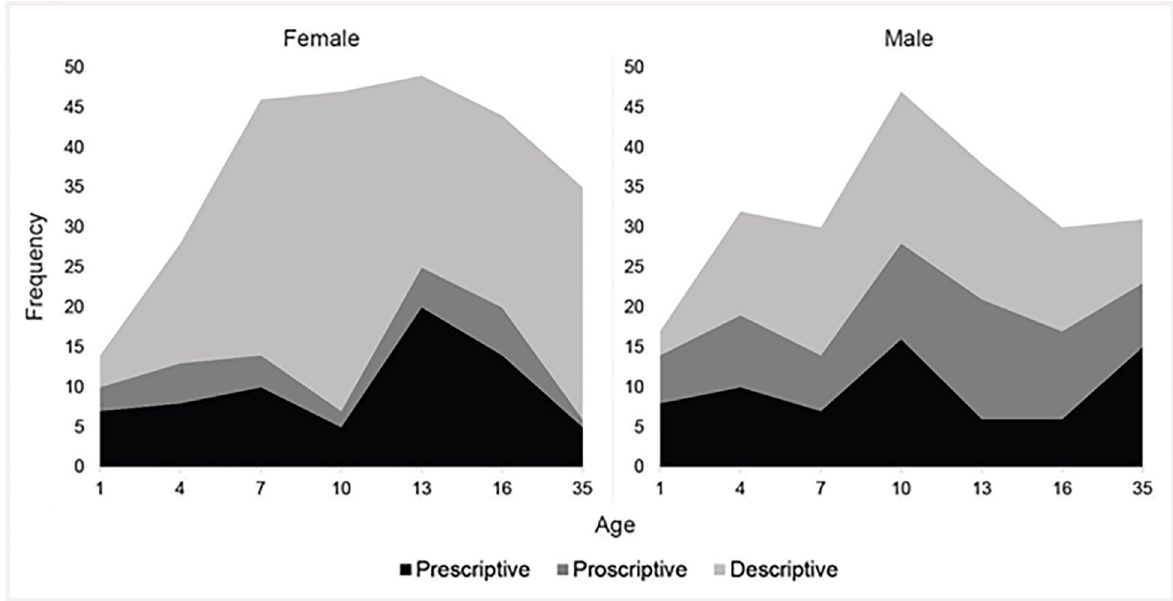
Fig 2. Number of characteristics classified as gender stereotypes at each age by type of stereotype. Notes . Y-axis is a count of stereotypes that met our pre-registered stereotype threshold. Black indicates prescriptive stereotypes, dark gray indicates proscriptions, and light gray indicates descriptive stereotypes. Note that some characteristics are double-counted (e.g., if an item was a descriptive and prescriptive stereotype at a particular age, it contributes to both the descriptive count and the prescriptive count). These data suggest that gender stereotypes are prevalent across the developmental timeline, and that children—not adults—may be subject to the most gender stereotypes.